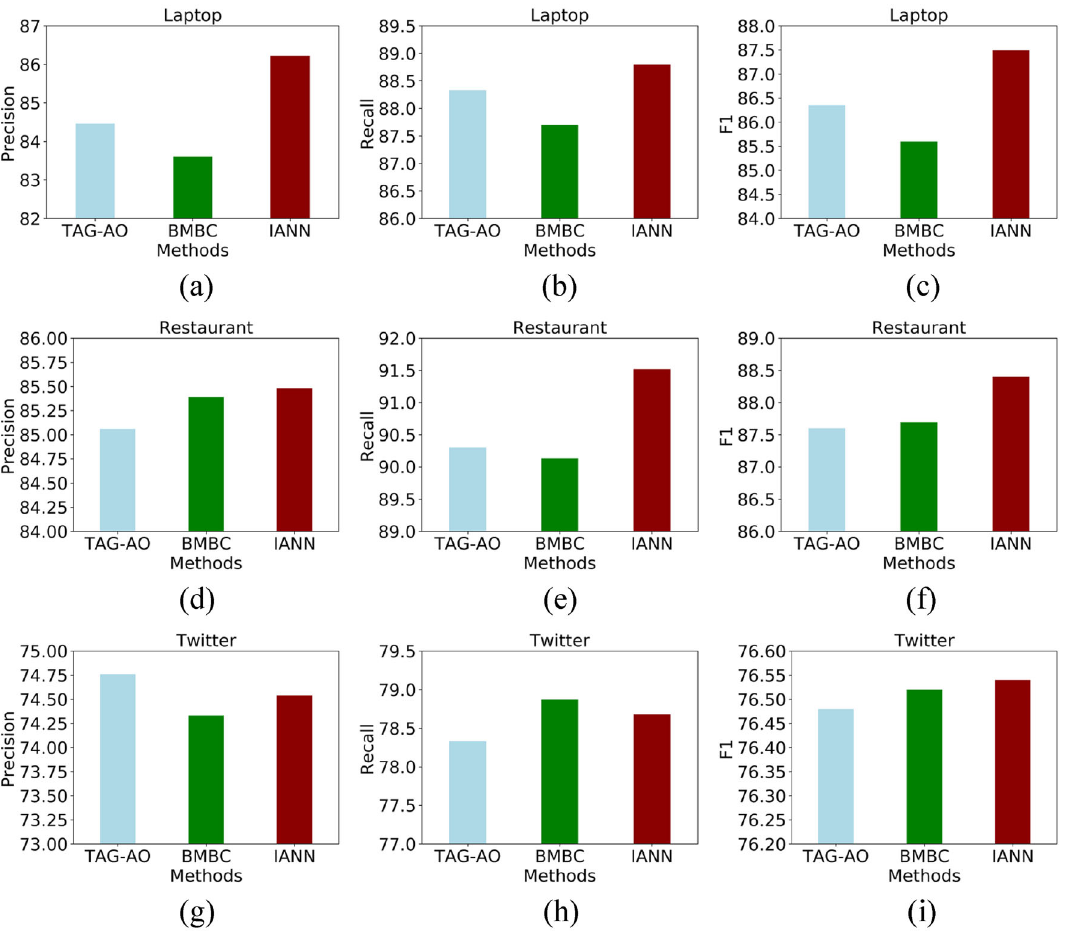
Fig. 8 The performance of different methods on three datasets with AO tags. a – c Show the performance in the laptop dataset, d – f show the performance in the restaurant dataset, g – i show the performance in the twitter dataset